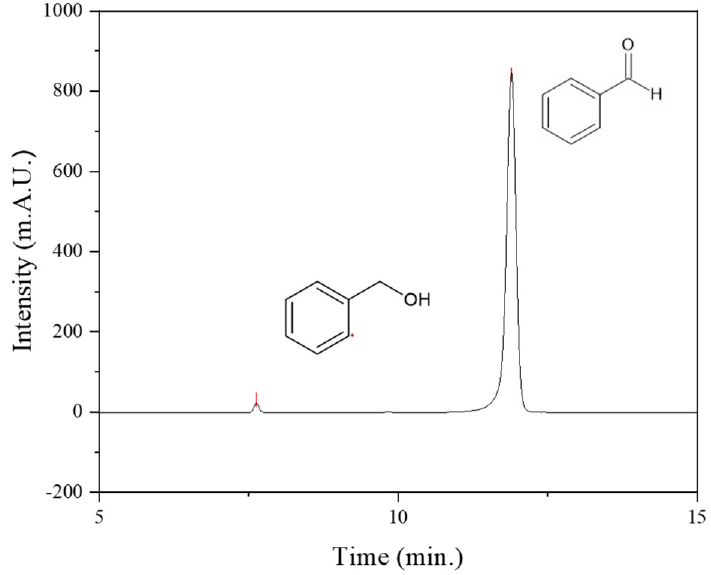
Figure 7. HLPC-DAD chromatogram of oxidation products of benzyl alcohol at 4 h. Benzaldehyde was the only reaction product, as confirmed by GC-MS.